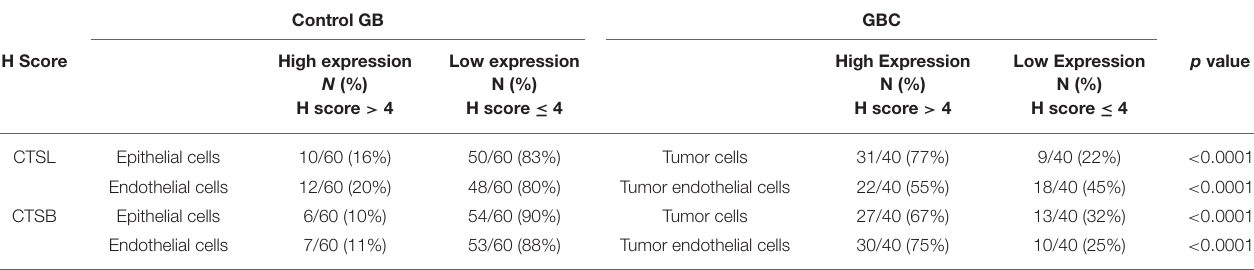
TABLE 3 | Assessment of cysteine cathepsin expression in gallbladder tissues by immunohistochemical analysis.